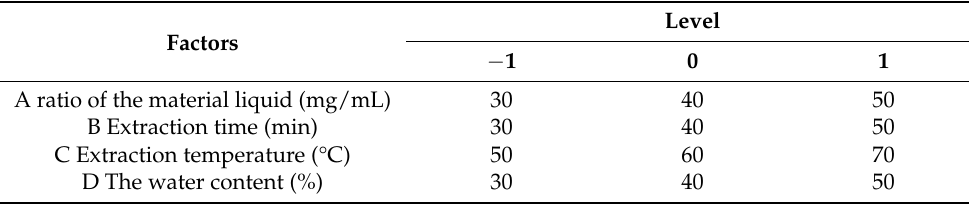
Table 4. Factors and levels in response surface analysis.